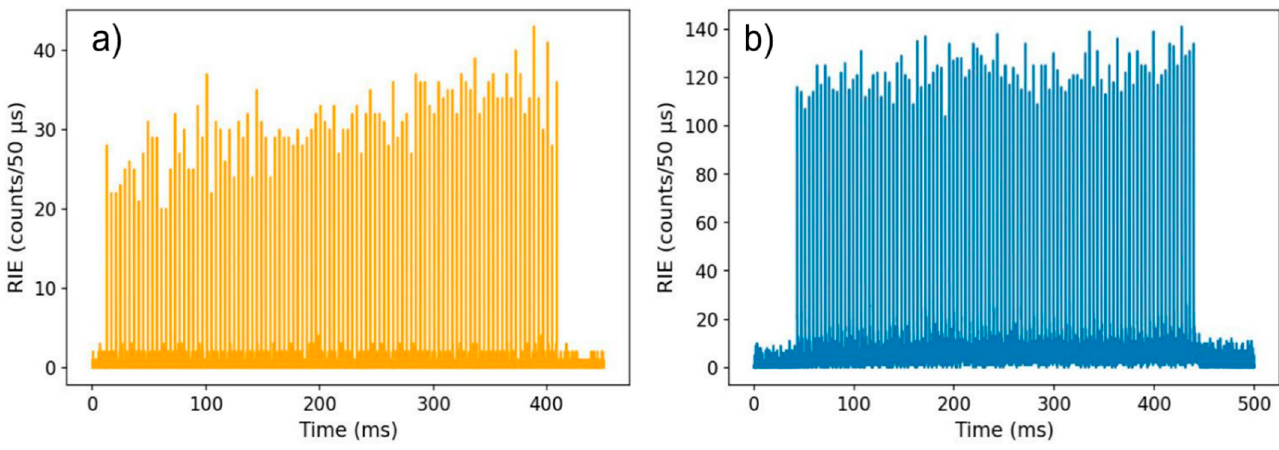
Figure 12. ( a ) RIE in the sole RHF produced by 100 pulses triggered at 250 Hz. ( b ) RIE in the coupled RHF and Ce ‐ doped OF produced by 100 pulses triggered at 250